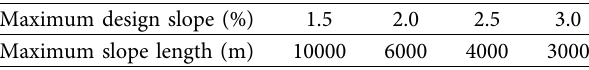
Table 10: Maximum slope length of high-speed railways.